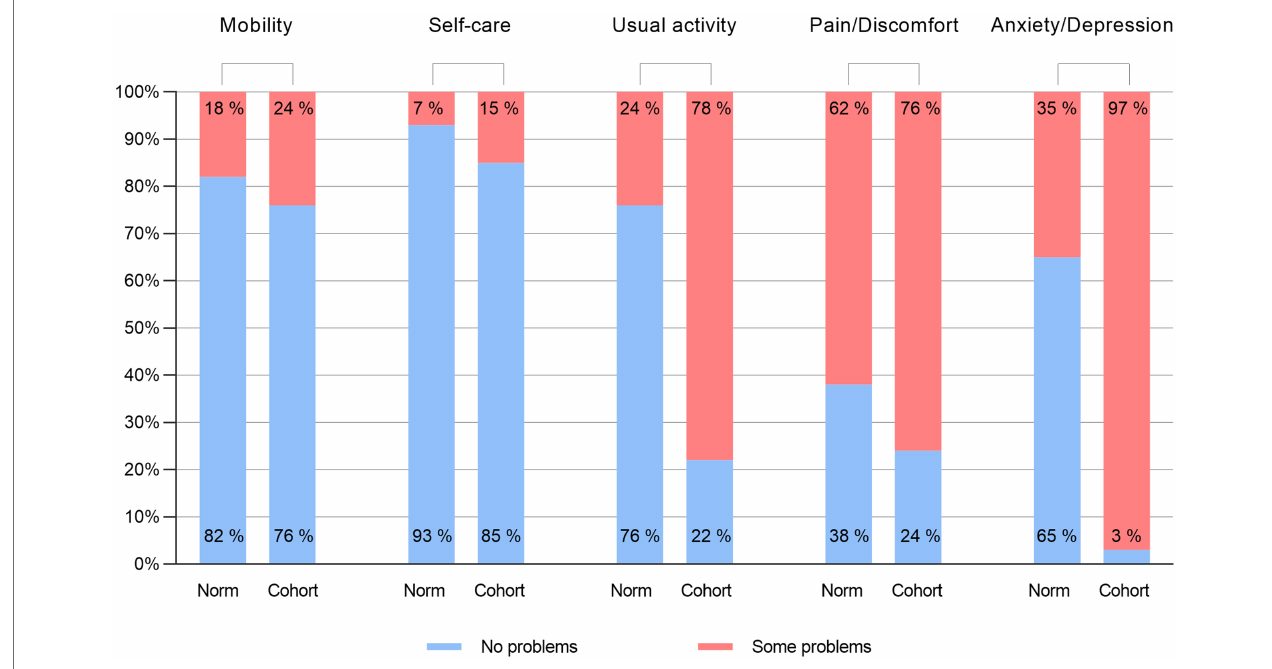
FIGURE 1 | Comparing proportion of EQ-5D “No problems” responses to the Norwegian general population. The “Cohort” columns represent the proportion of patients in the current study who reported “No problems” on each dimension of the EQ-SD compared to the patients who reported any other level of severity. The “Norm” columns represent the same proportion from the study that collected Norwegian population norms; respondents who reported “No problems “on the various dimensions compared to all other levels of severity (Garrat et al., 2021). Percentages are rounded to the nearest integer.